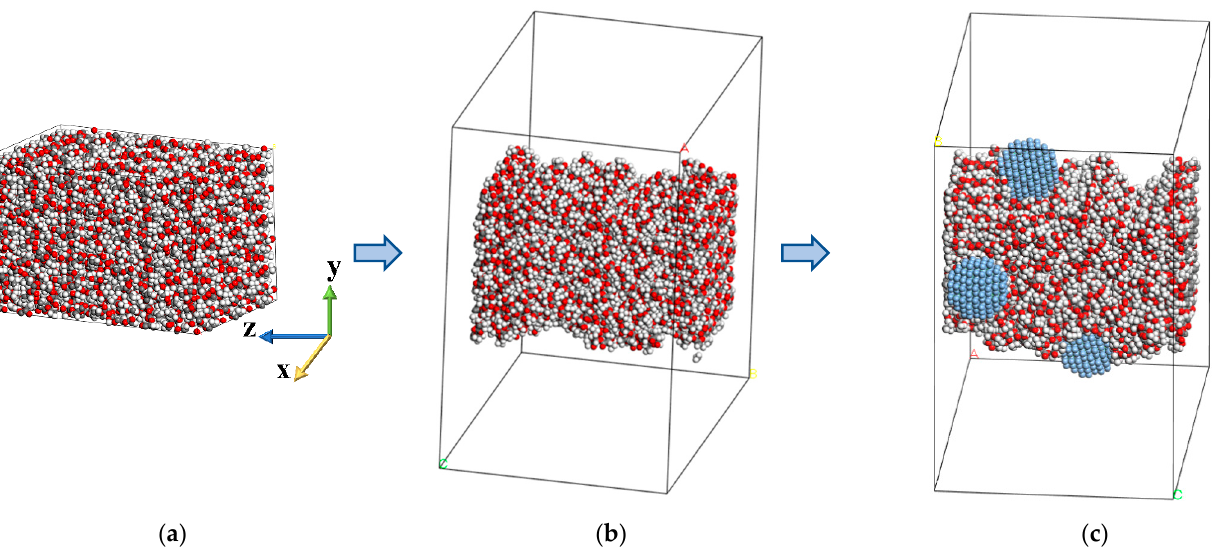
Figure 3. ( a ) Initial cuboid. ( b ) Relaxed nanofibre in the enlarged cell. ( c ) Doping silver nanoparticles on nanofibre.